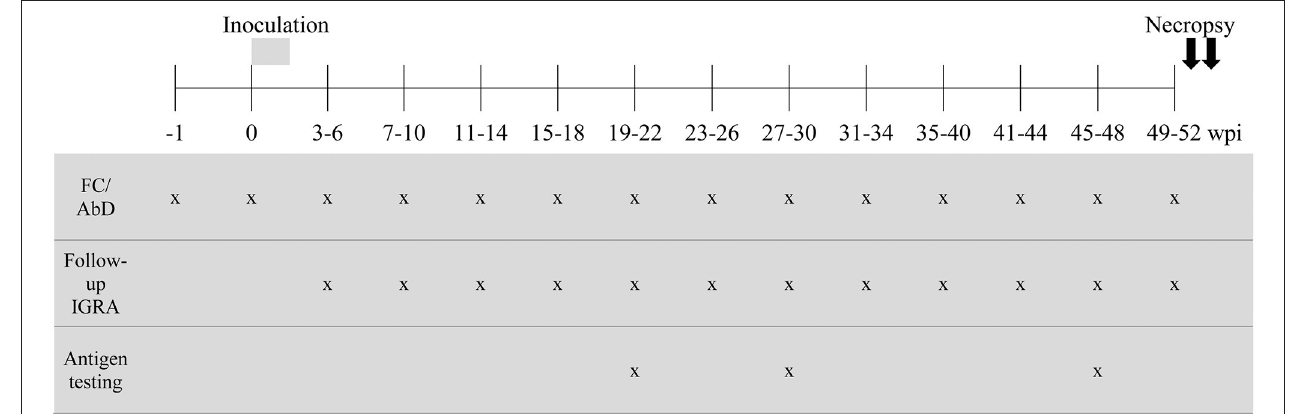
FIGURE 1 | During the course of the experiment, fecal samples and blood were collected 1 week before the start of the inoculation period ( − 1 wpi), directly before the first inoculation (0 wpi) and then in regular intervals until 49–52 wpi. The goats were divided into four sampling subgroups, consisting of 2 animals of each treatment group, that were sampled 7 days apart such that all animals were sampled once every 4 weeks. The results of one 4-week period were taken together to form one time period for analysis.